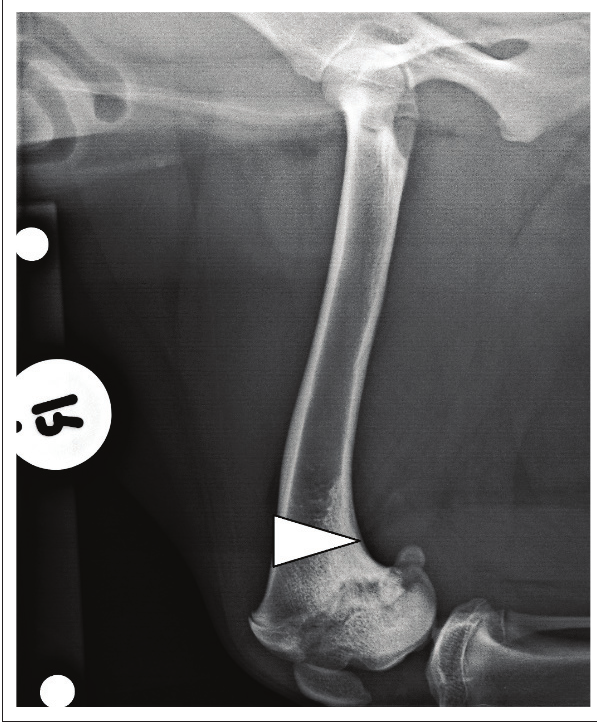
FIGURE 4: Radiographic image: Preoperative mediolateral view of the right femur. A 23° cranially based closing wedge ostectomy was